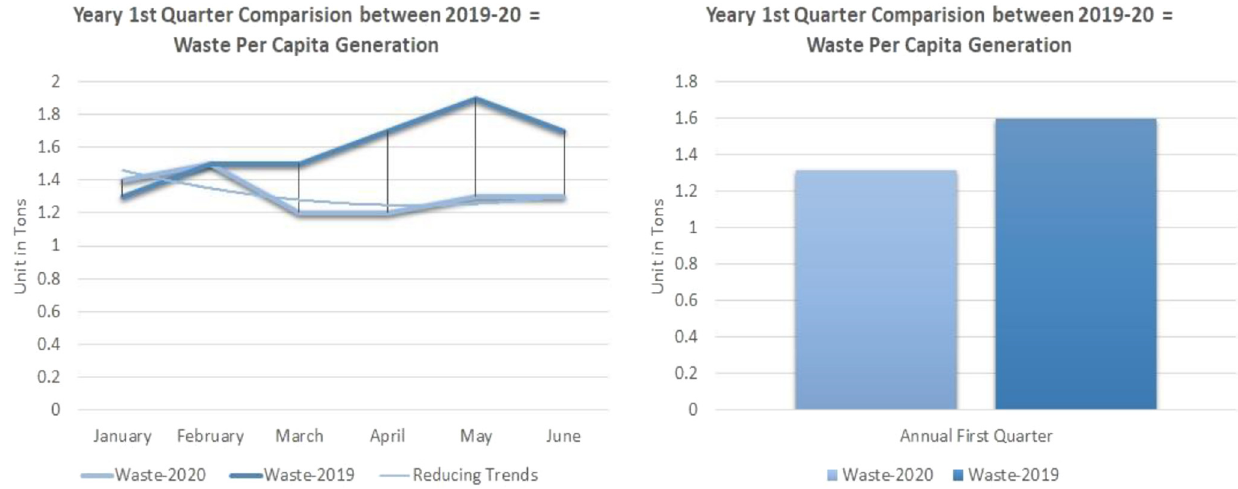
Fig. 10. Waste per capita generation 2019 – 2020 (Ajman (cid:1) UAE) [15].